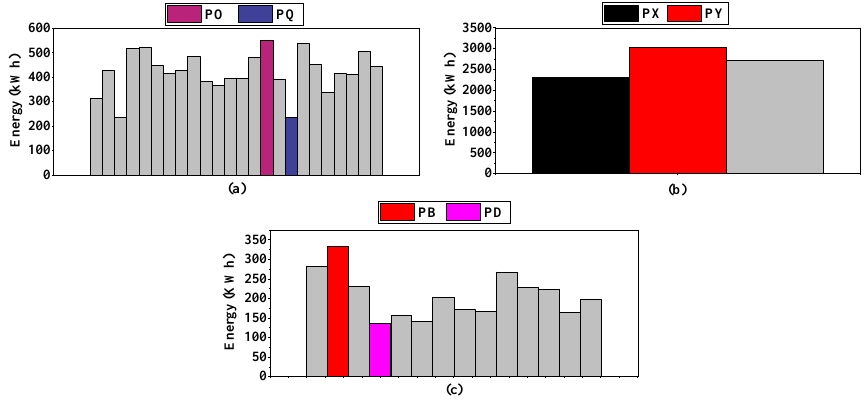
Figure 11. Minimum and maximum excess energy obtained by individual apartments from Consumption-based Allocation (CA) strategy: ( a ) Evermore, ( b ) Gen Y, and ( c ) SHAC.